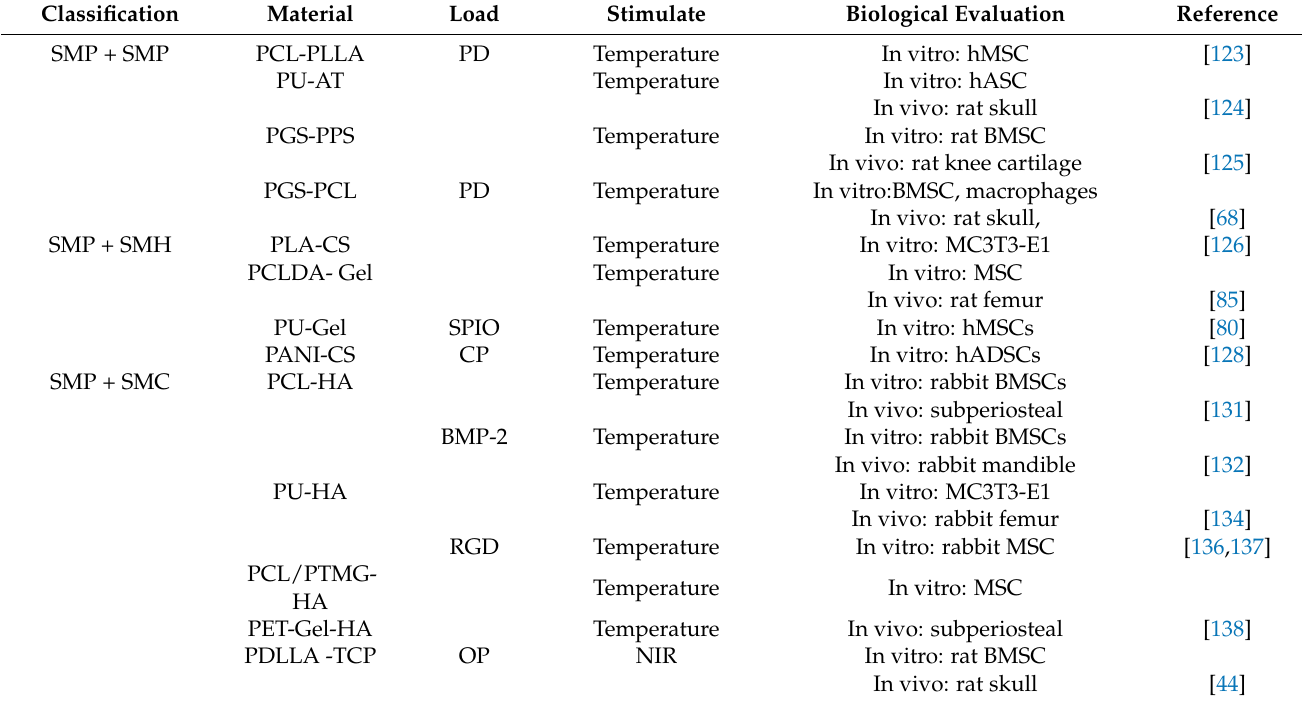
Table 3. Different hybrid shape memory materials in bone tissue